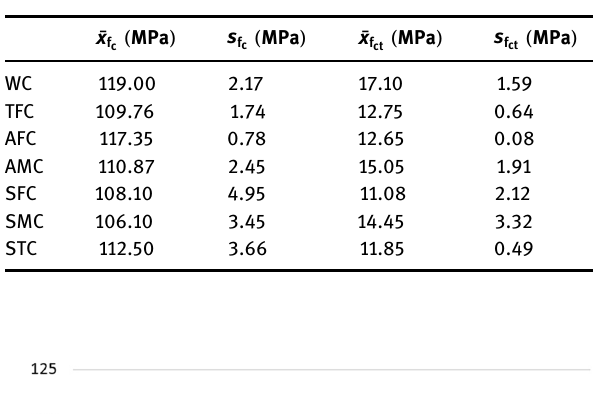
Table 4: Results for compressive strength and splitting tensile strength